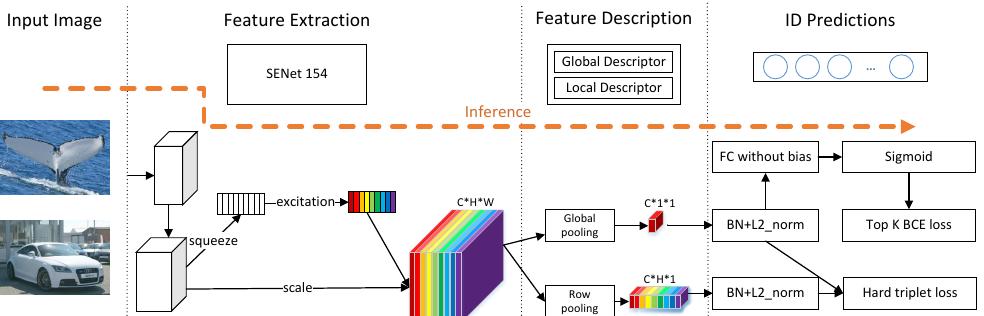
Figure 2. Model overview. Our model consists of two key modules, an image feature extraction module and a description module. The final predicted ID scores are obtained by the global descriptor without bias through the FC layer and a sigmoid